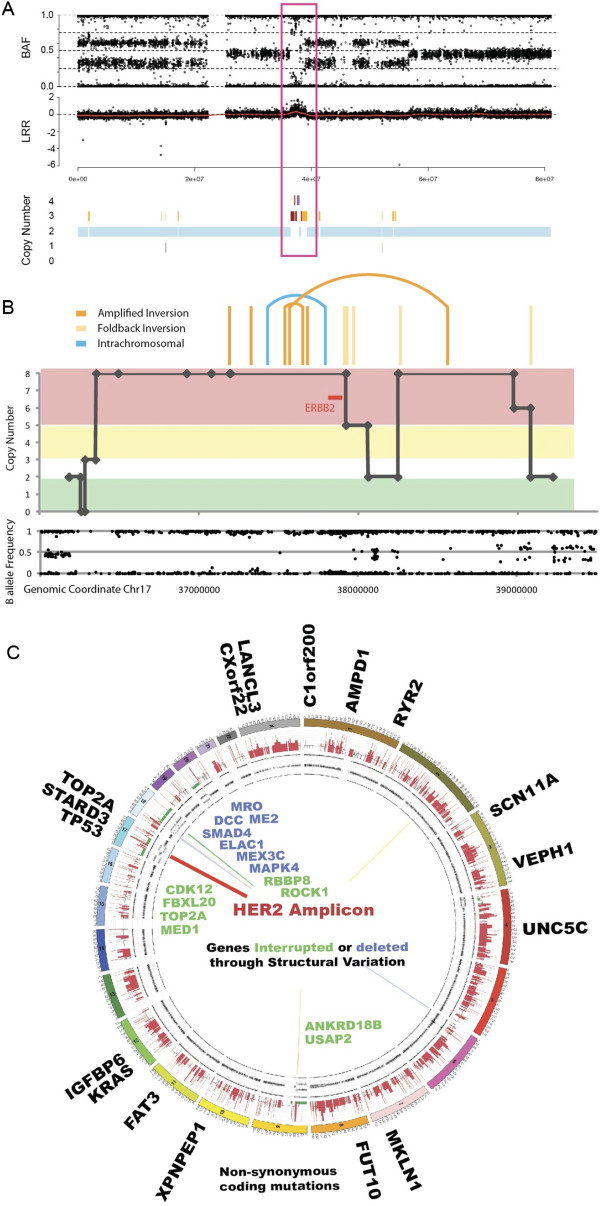
HER2-amplified pancreatic ductal adenocarcinoma. (A) Single nucleotide polymorphism (SNP) array showing amplification on chromosome 17 containing the HER2 locus (boxed). (B) Inverted amplification on chromosome 17, spanning HER2 and truncating MED1 and TOP2A at either end (chr17:37,565,271-38,554,848). (C) Circos plot showing mutations and structural rearrangements of patient 9 (Table 2). Genes with non-silent substitutions are shown on the outer wheel. The SNP array data are shown on the subsequent plots (copy number predictions and B-allele frequency of probes). Structural rearrangements are indicated with lines inside the circle: deletions (green), inversions (yellow), intra-chromosomal rearrangements (blue), foldback inversions (light orange), and amplified inversions (dark orange). Genes with structural variation are shown in blue if deleted and green if interrupted.